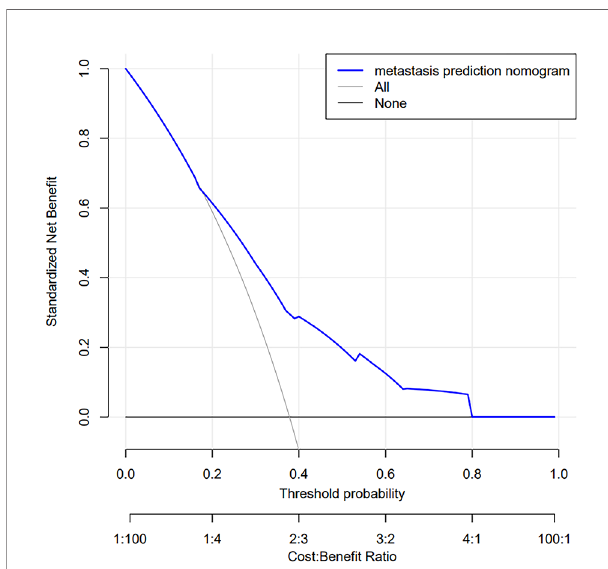
FIGURE 7 | Decision curve analysis (DCA) for the risk nomogram. DCA shows that the model is clinically useful when intervention is decided in the threshold range of 16% to